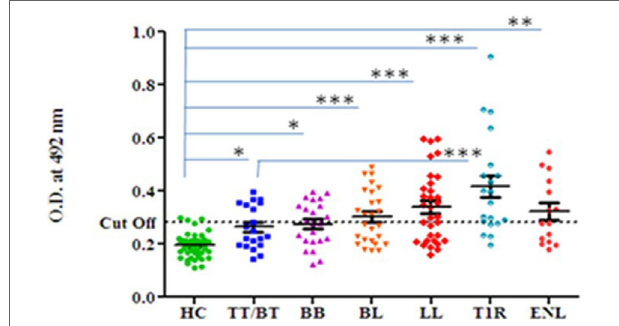
FigUre 1 | Level of antibodies against myosin in leprosy patients across the spectrum and healthy controls (HC). Dotted horizontal line represents the cutoff OD value. Smooth line with vertical lines represents the mean OD value with SEM of each group. Each dot represents the OD value at 492 nm obtained from each individual. One-way ANOVA (and non-parametric) test and post-test used was Newman–Keuls multiple comparison test to find out the difference between OD value obtained in the sera of HC and leprosy patients (*** p value < 0.0001, ** p value < 0.001, * p value <